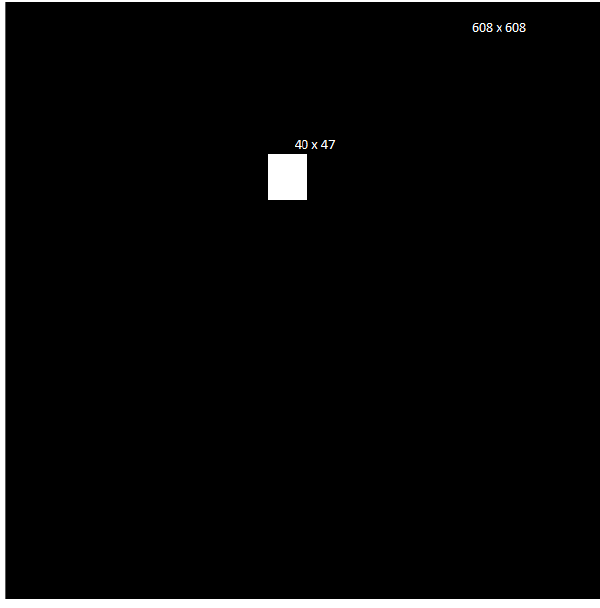
Figure 18. Minimum size of object